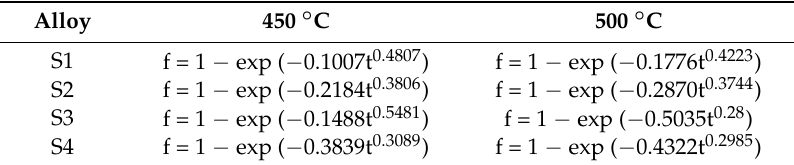
Table 4. The Avrami-equation of phase transformation of alloys.